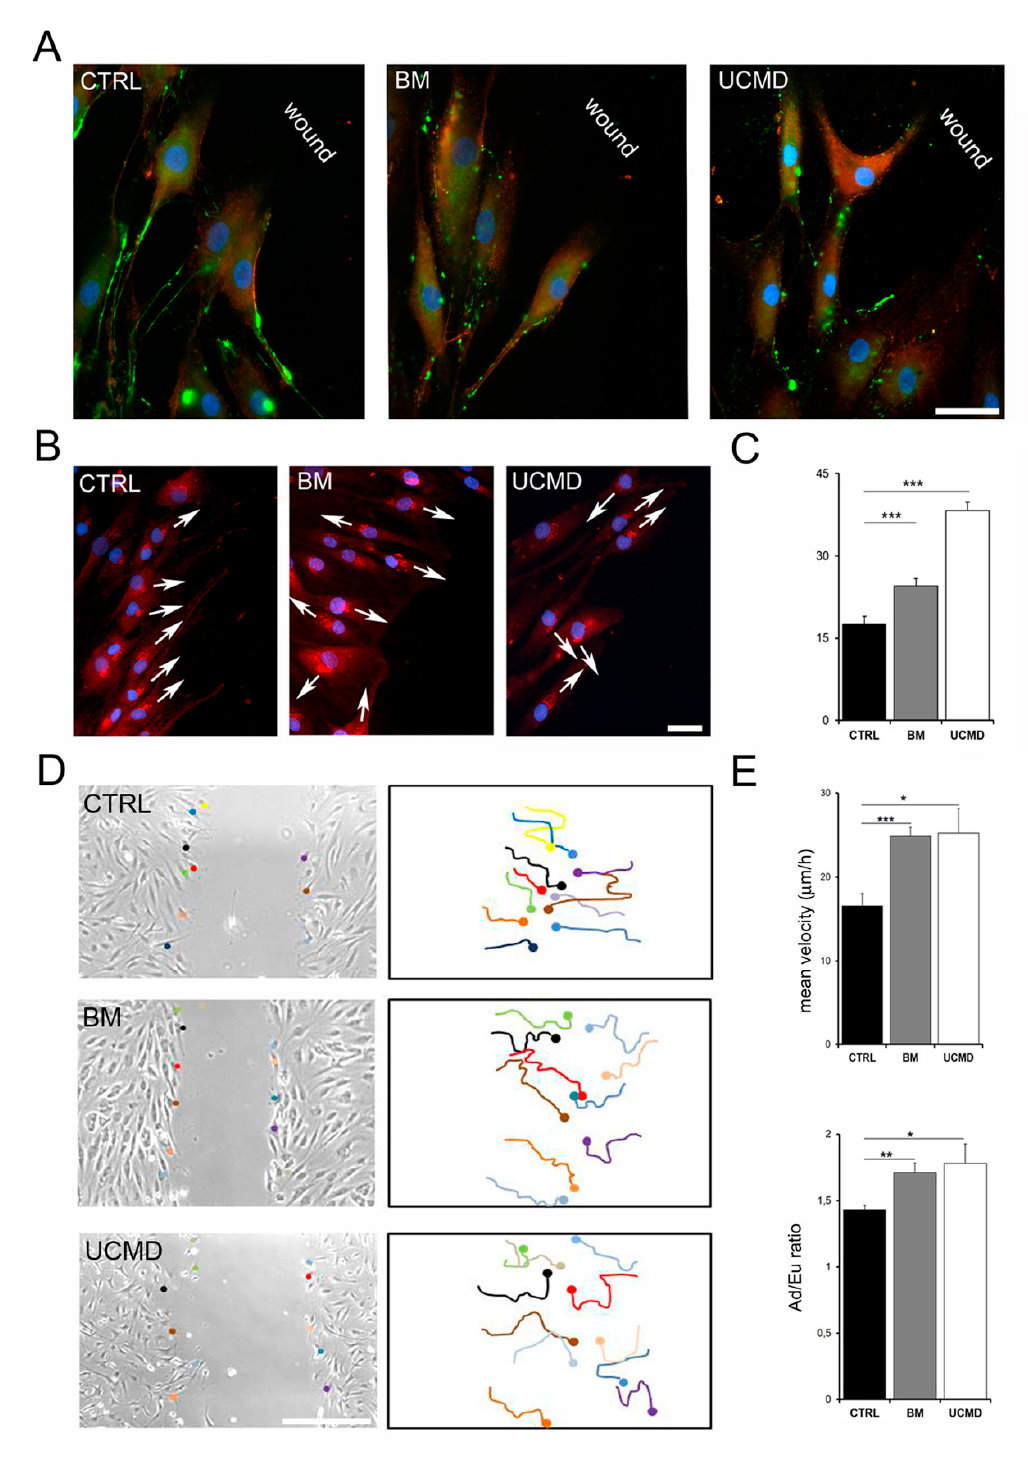
Figure 3. Disruption of collagen VI-NG2 axis affects BM and UCMD cell polarization during migration. ( A ) Immunofluorescence microscopy of collagen VI (COL6) and NG2 double-labeled cells subjected to scratch wound assay. Collagen VI microfilaments and NG2 co-localize at the rear of control (CTRL) cells. In BM and UCMD migrating cells, collagen VI and NG2 staining appears reduced, with a spot-like pattern. Nuclear staining, DAPI. Scale bar, 50 µ m. ( B ) Immunofluorescence microscopy of Golgin-97, a marker of the Golgi apparatus, in tendon fibroblasts subjected to the scratch wound assay. In migrating cells of the control (CTRL), the Golgi apparatus was located